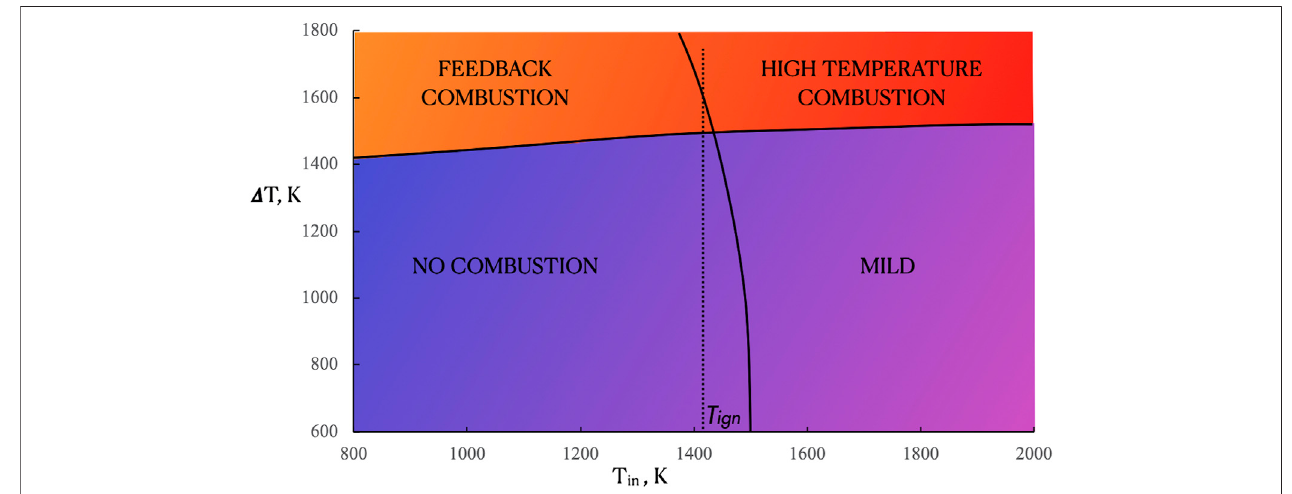
FIGURE 10 | Map of behavior for pure ammonia in the HODF con fi guration at P (cid:1) 1 atm.